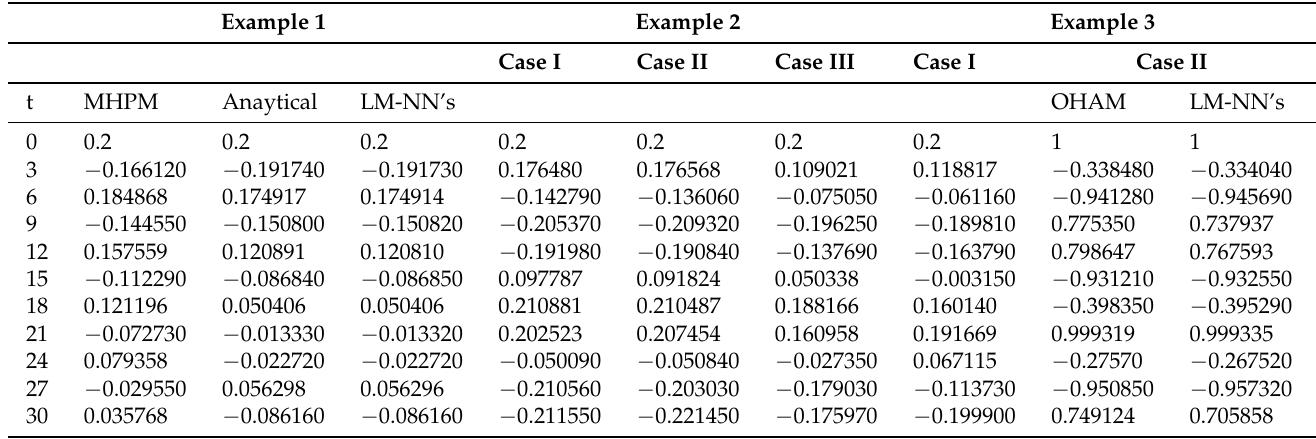
Figure 11. Studies based on the performance of MSE by the design scheme, for multiple examples. Table 2. Approximate solutions obtained by the LM-NN algorithm for different examples of the rolling motion of ships in random beam